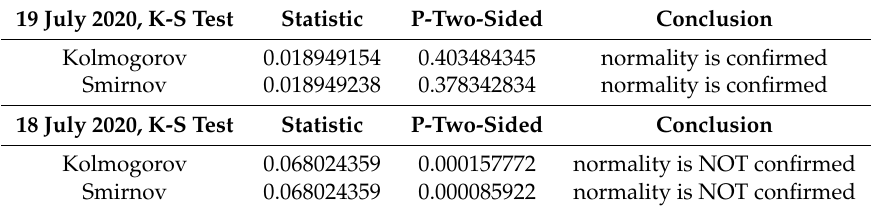
Table 2. The table shows examples of Kolmogorov and Smirnov tests of (statistics, two-sided p -value and output), for 18 and 19 July 2020 at 5 GHz (RCP) (threshold value is 0.05). As can see, on 19 July the data had a normal distribution, but not on 18